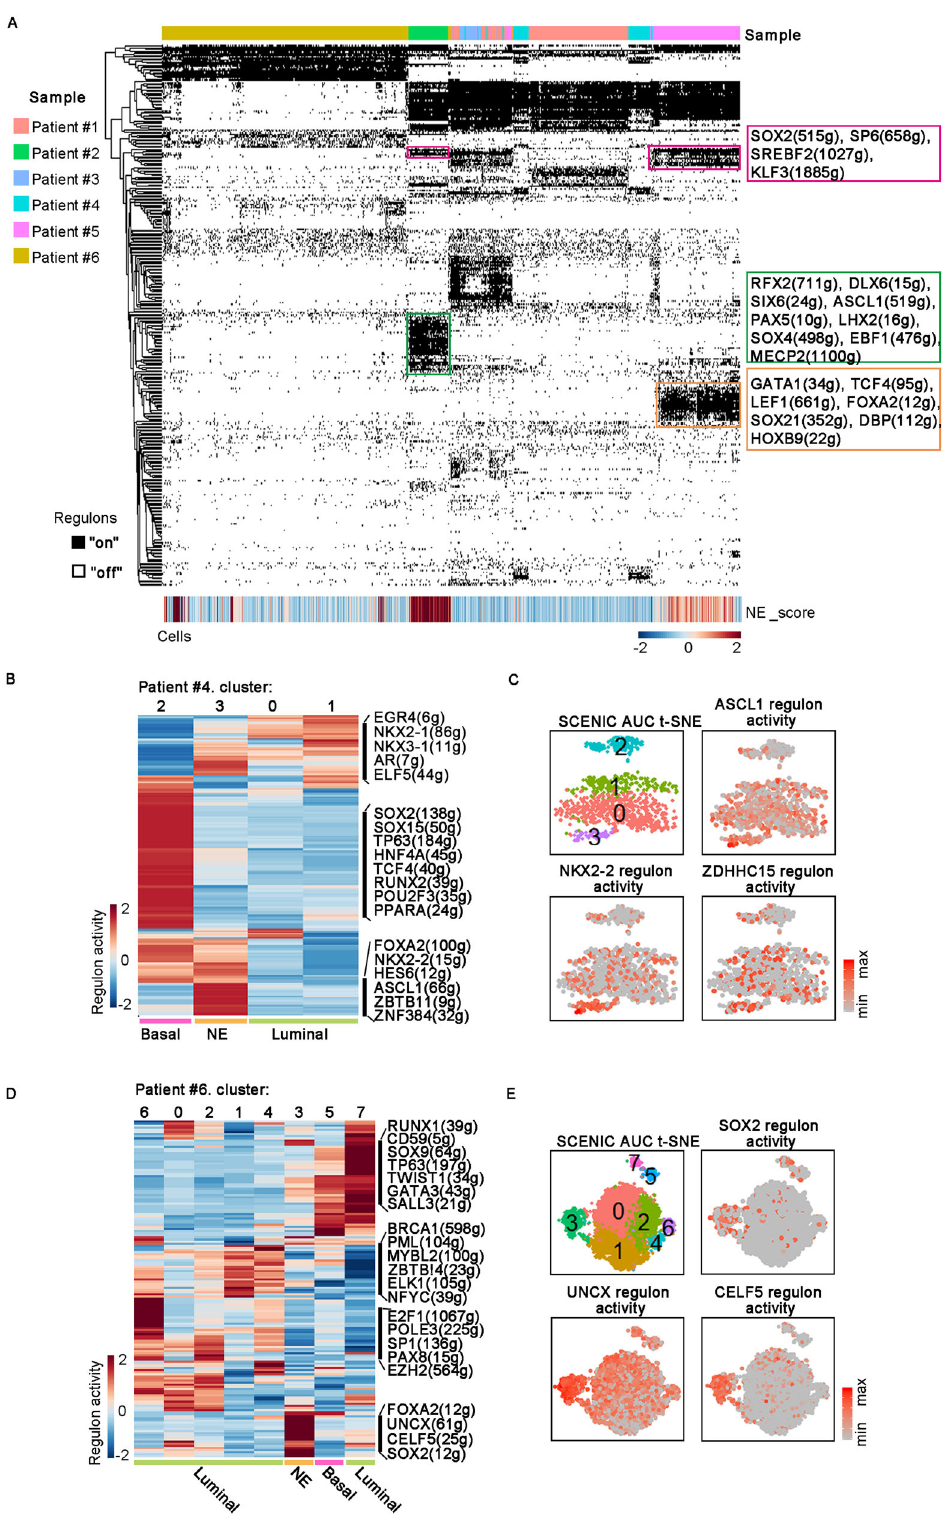
Fig. 7 Transcription-factor regulatory networks underlying NED. A Heatmap of SCENIC binary regulon activities (row) and NE scores (row) of 12,861 epithelial cells (column). Three TF regulatory networks with high activities in NE cells were highlighted. B Heatmap of the mean regulon activities (row) that differentially expressed on epithelial clusters (column) of patient #4. C t-SNE on the SCENIC regulon activity matrix and the representative regulon activities on epithelial cells from patient #4. Cells are colored by the corresponding cluster and gradient of regulon activity (gray to red). D Heatmap of the mean regulon activities (row) that differentially expressed on epithelial clusters (column) of patient #6. E t-SNE on the SCENIC regulon activity matrix and the representative regulon activities on epithelial cells from patient #6. Cells are colored by the corresponding cluster and gradient of regulon activity (gray to